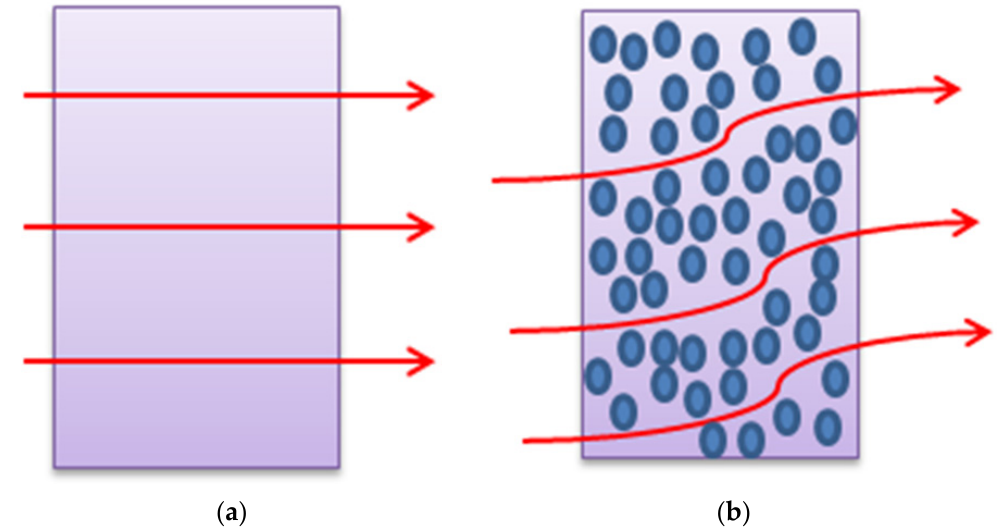
Figure 3. Comparative diagram of diffusion phenomena. ( a ) Homogeneous material, ( b ) Heteroge- neous material.